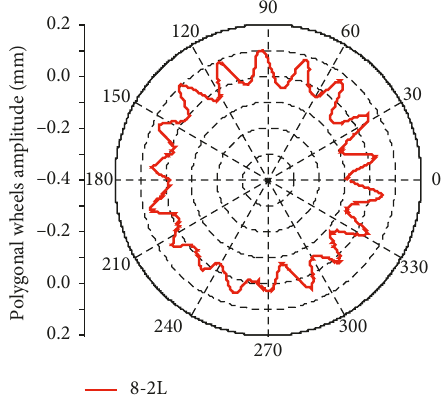
Figure 11: CRH3 wheel polygonalisation.